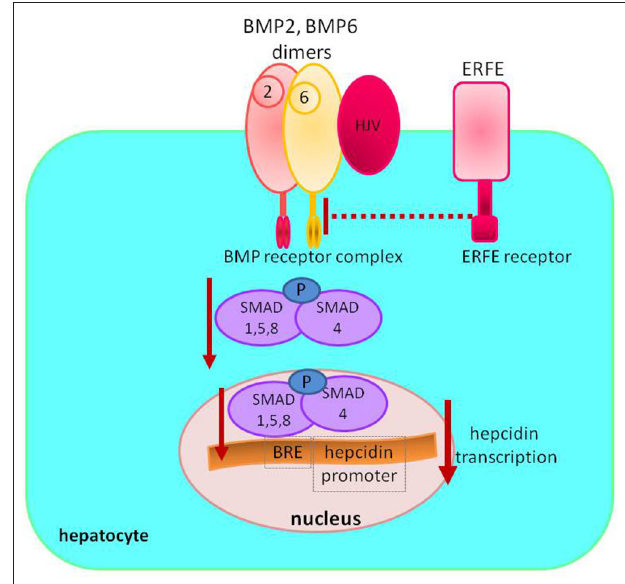
labile plasma iron (LPI), may circulate (20). LPI may pose the